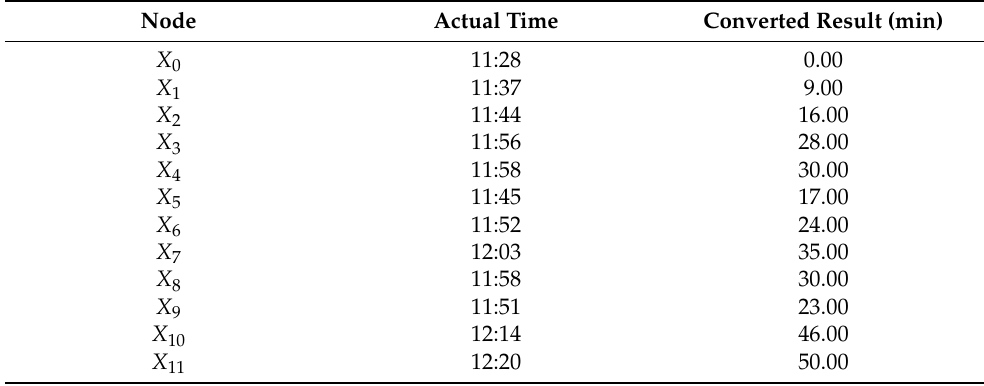
Table 3. Sample of ground handling process